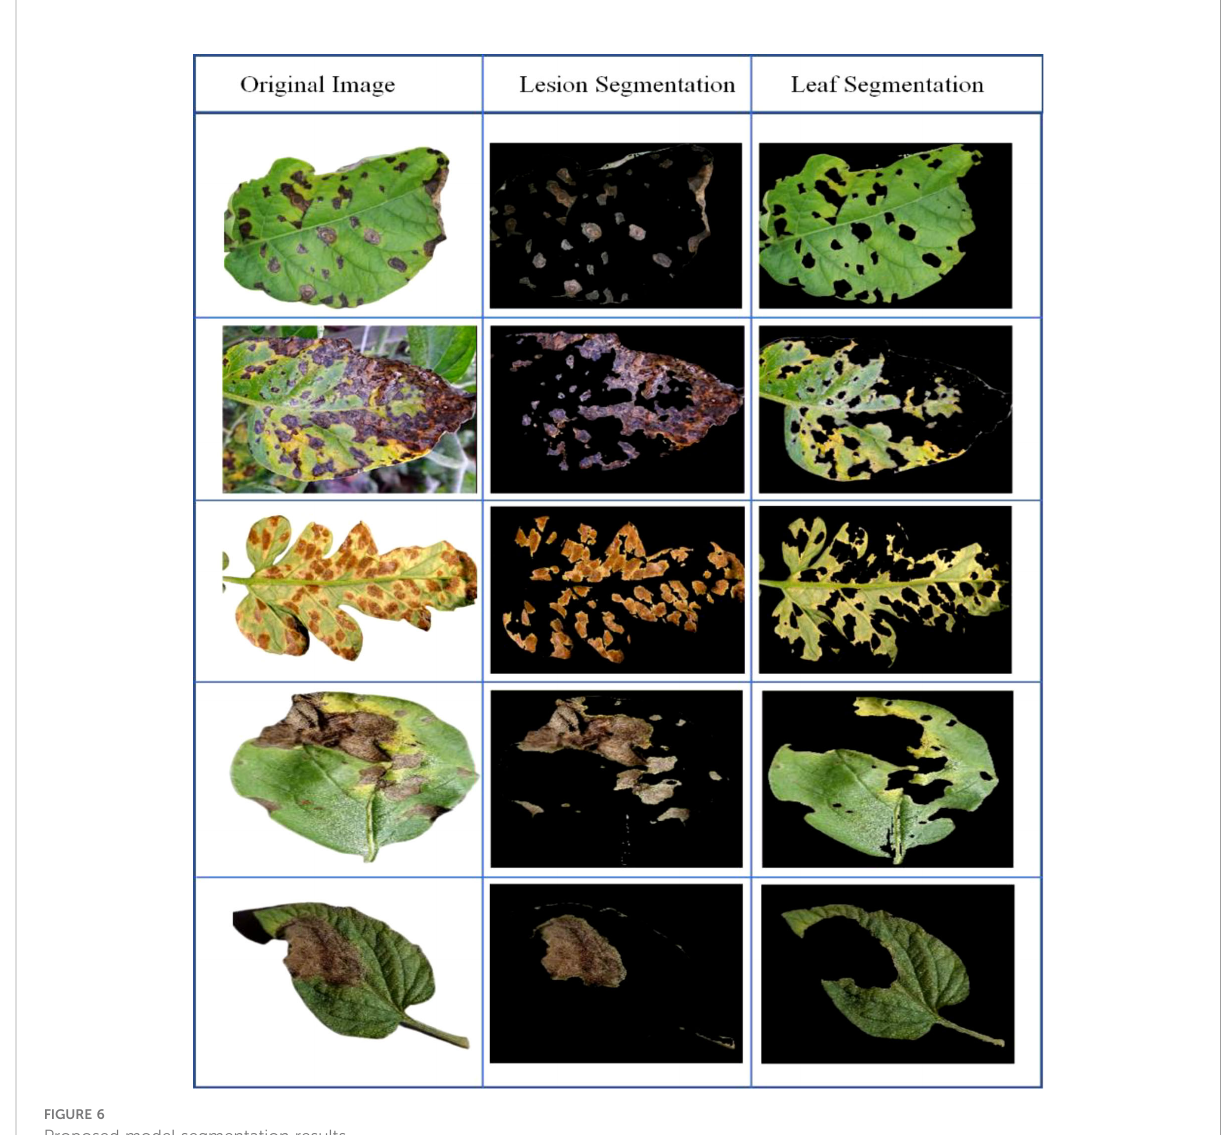
FIGURE 6 Proposed model segmentation